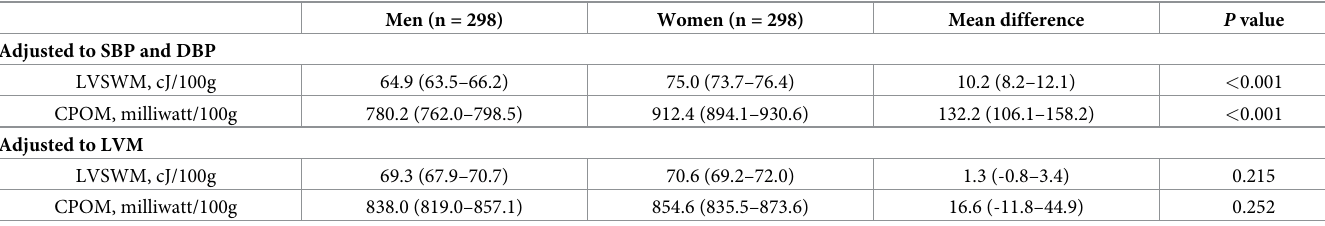
Table 2. Sex differences in LVSWM and CPOM in 596 apparently healthy adults after adjustment for the blood pressure or the LVM.